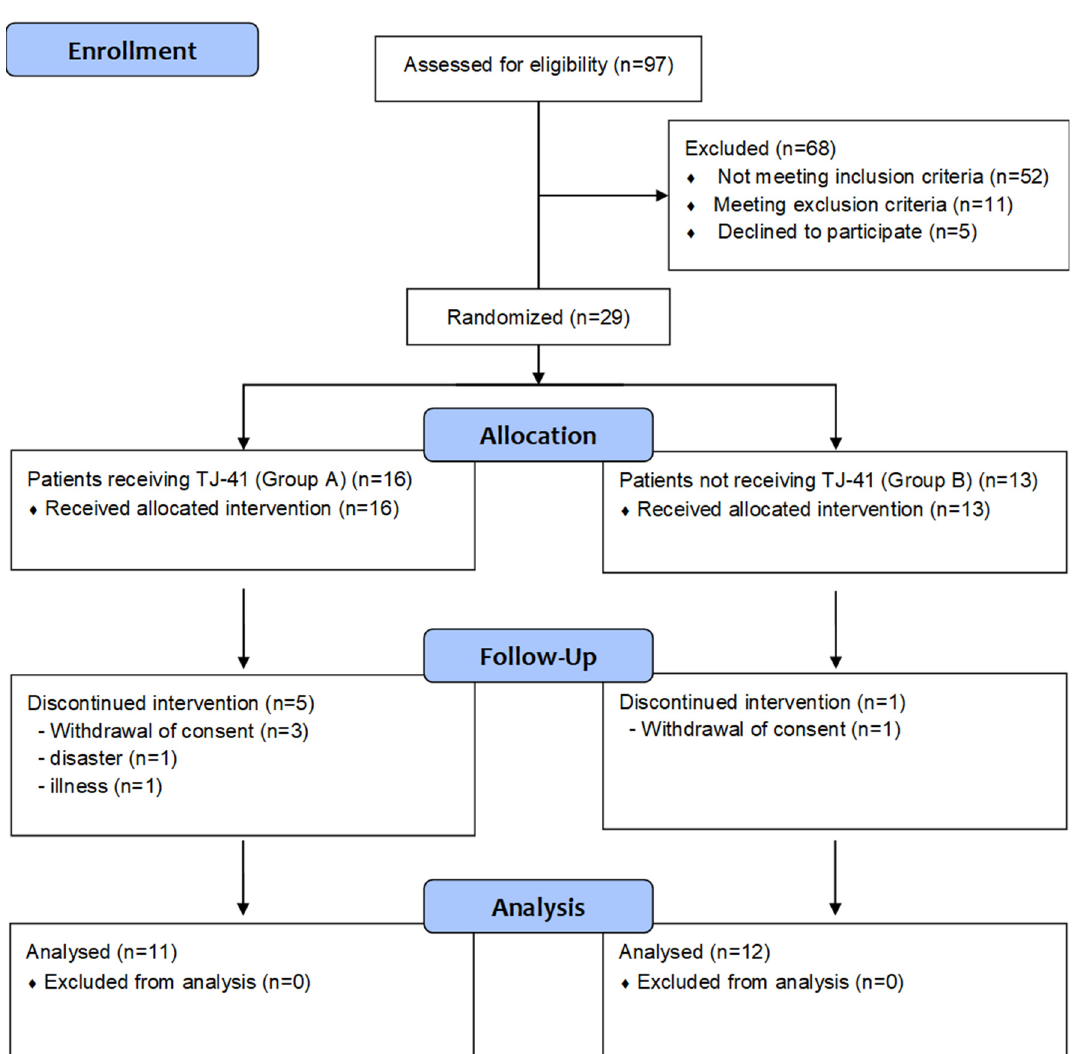
Figure 1. CONSORT flow diagram.